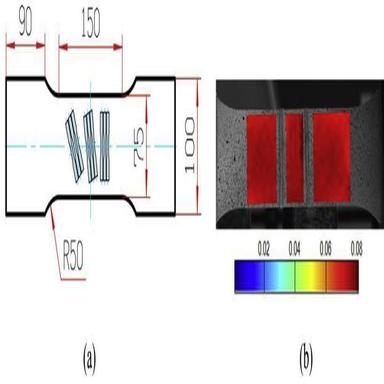
Specimens used in the tension-tension tests: (a) large sample with small samples machined from the gauge region, and (b) strain maps in the gauge region of the large tensile sample evaluated at an engineering strain of 0.08. The equivalent von Mises strain εVM is applied as a convenient measure of the two-dimensional strain field extracted by DIC.